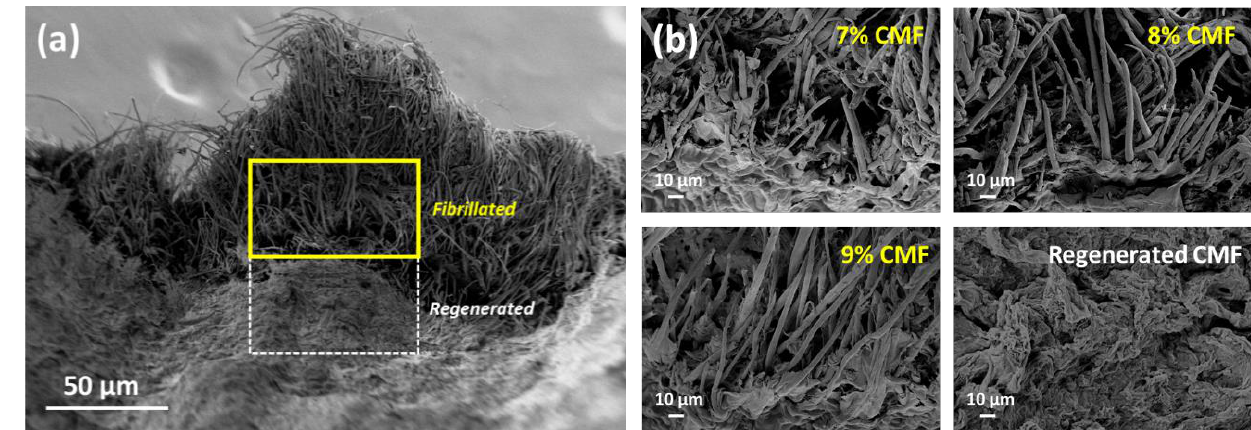
Figure 5. ( a ) Morphological differences of partially regenerated CMFs; ( b ) different cellulose concentrations with fibrillated and regenerated CMF structures. Table 1. Cellulose I and cellulose II fractions at CMF different concentrations.